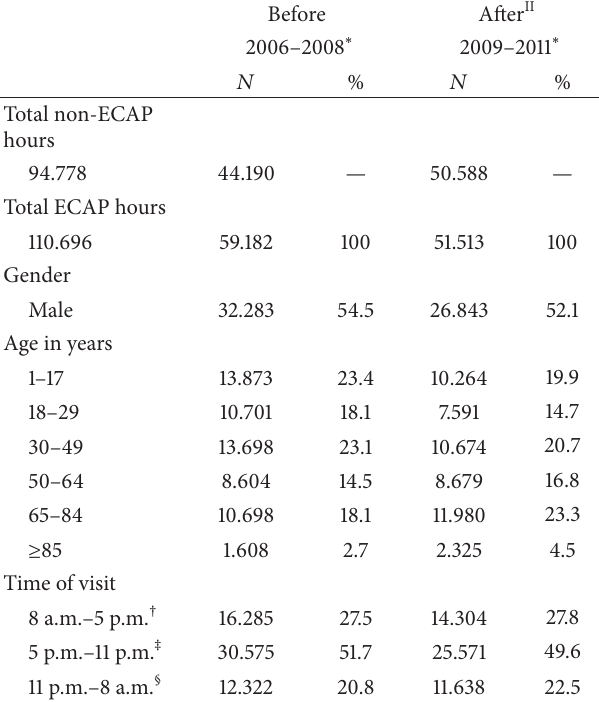
Table 1: After-hours ED patient characteristics; numbers and percentages of patients, total of 3 years before and 3 years after the start of the